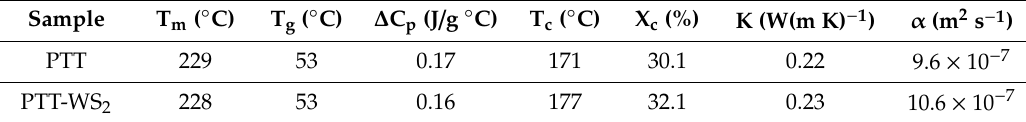
Table 1. Thermal properties of PTT and nanocomposite (PTT-WS 2 ) [9]: T m (melting temperature), T g